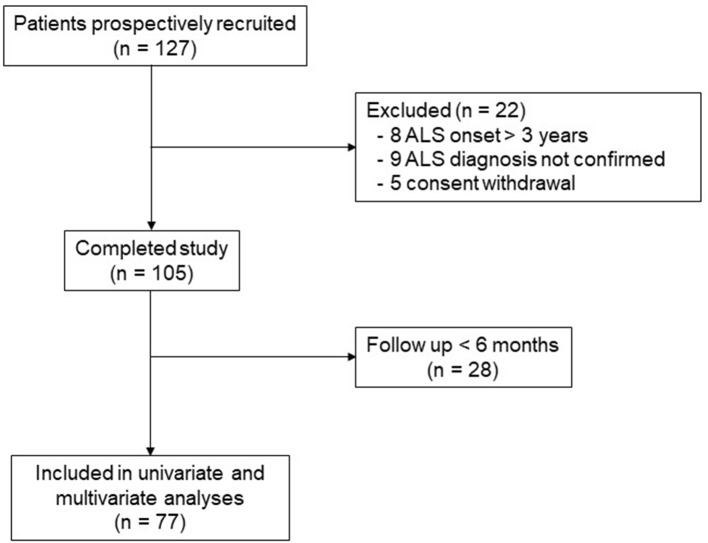
Study flowchart.